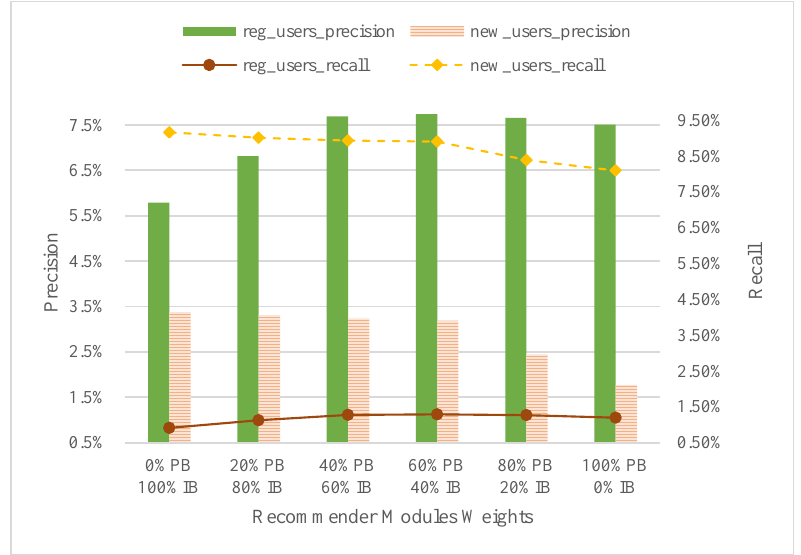
Figure 6. Precision and recall comparison of regular users and new users, using different content- based modules weights.